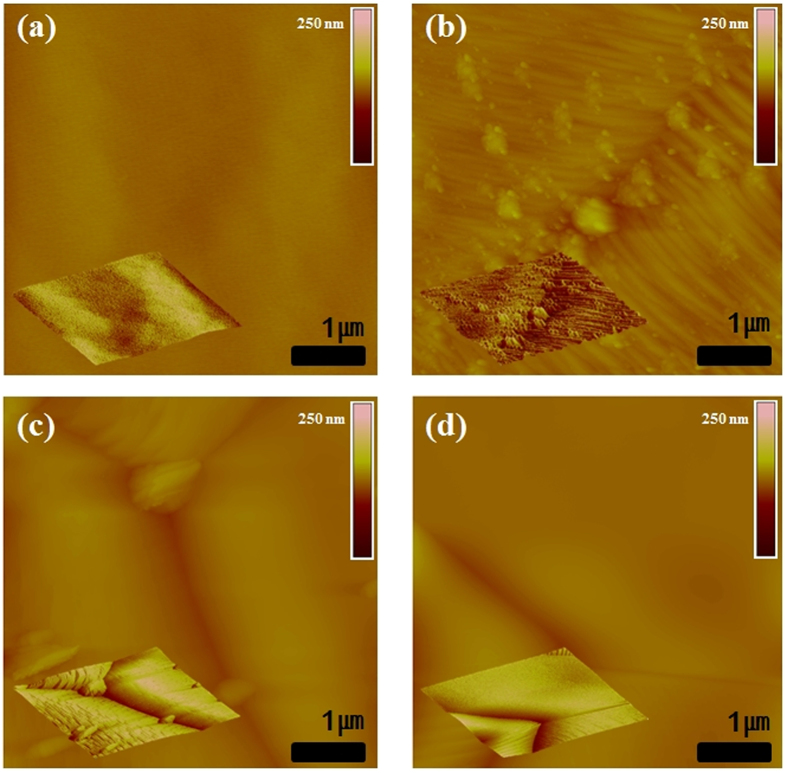
The comparison AFM images of (a) the raw Ni foil, (b) the Ni foil with LPH2, (c) the Ni foil with ECP/LPH2 and (d) the Ni foil with ECP/APH2.